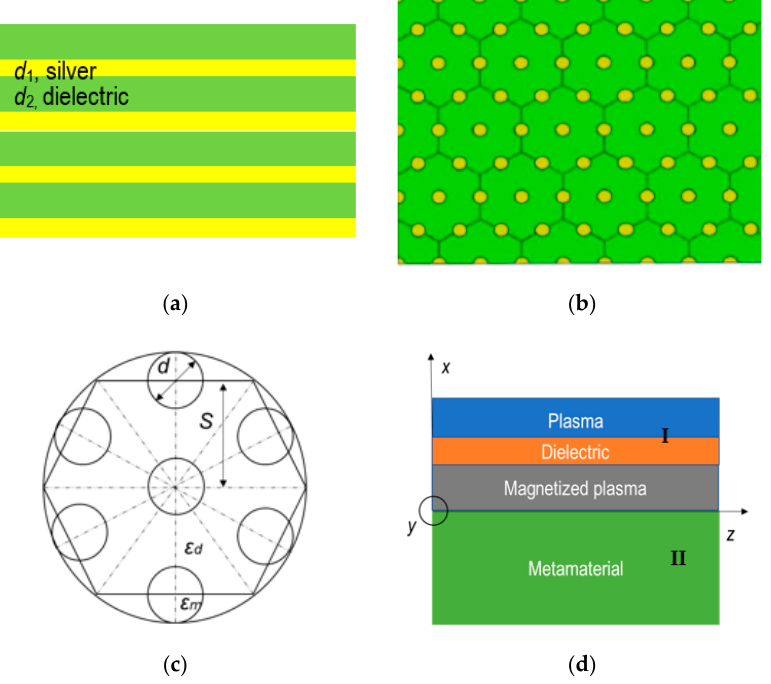
Figure 1. Engineering hyperbolic metamaterials. ( a ) Nanostructured metamaterial comprising os- cillating metallic and dielectric layers resulting in a metal–dielectric nanostructure. ( b ) Nanowire metamaterial composed of metallic nanorods implanted in a dielectric material. ( c ) Enlarged view of the nanowire metamaterial unit cell. In both ( a , b ), the constituent components are subwave- length, permitting application of effective medium theory. Herein, d is the diameter of nanowires. ( d ) Structure under consideration with the SPPs propagating along the z